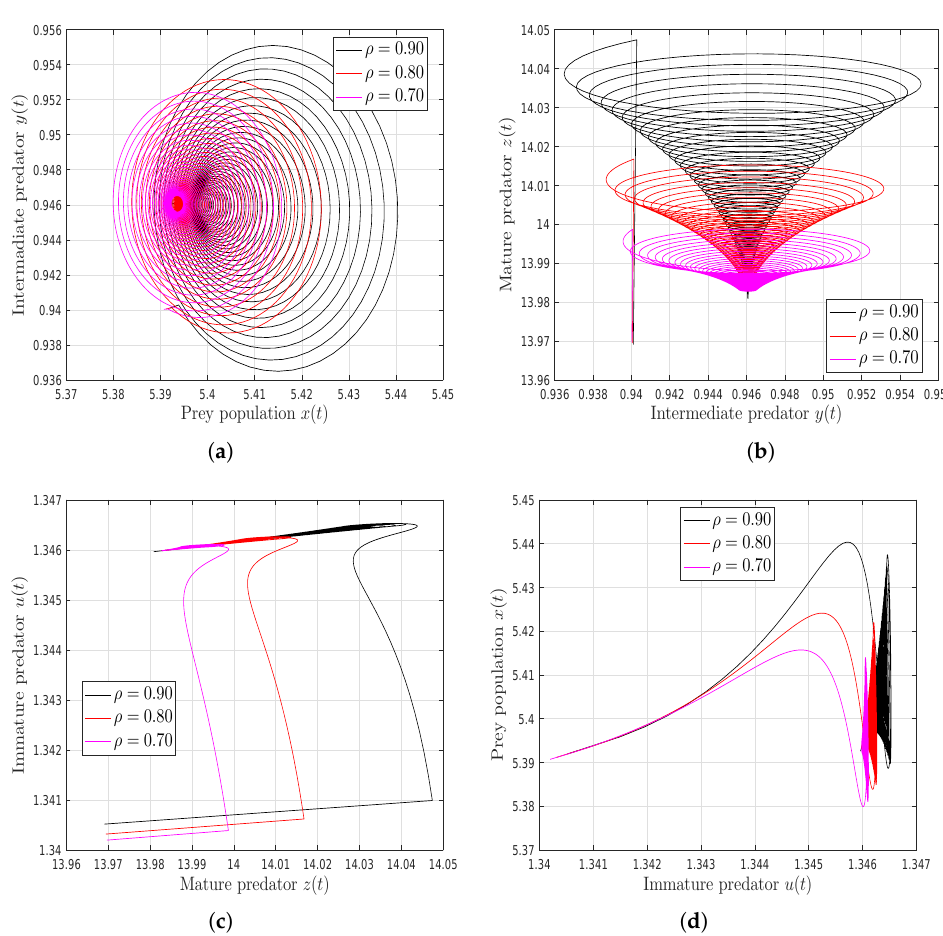
Figure 11. Two-dimensional chaotic phase plot for food web mathematical System (13) with general- ized Caputo fractional operator when ϕ = 0.90.